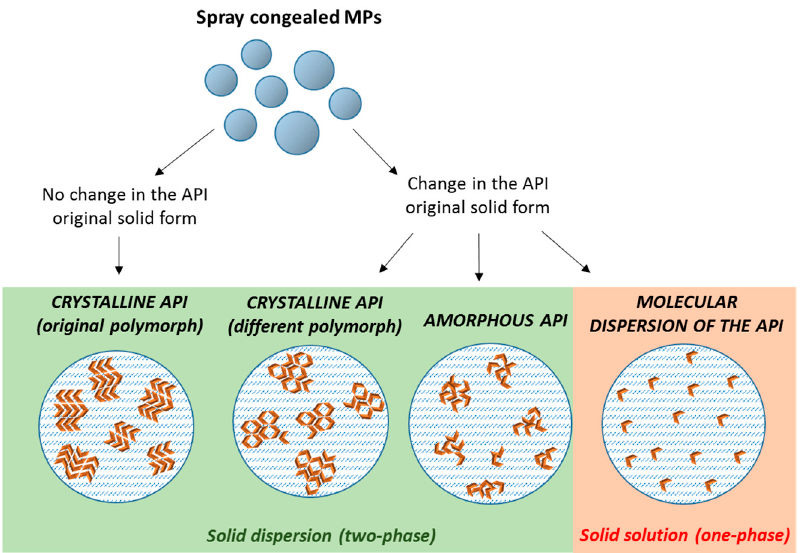
Figure 2. Scheme depicting the di ff erent type of solid dispersions that can be obtained by spray congealing (orange arrows represent individual API molecules).